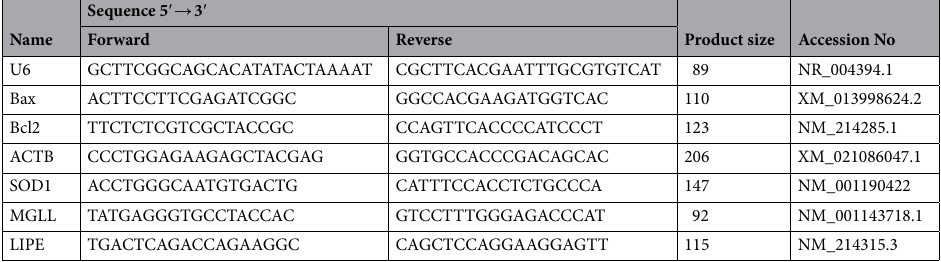
Table 1. Primers used for RT-qPCR. U6 RNU6-1 RNA, U6 small nuclear 1 ( house-keeping snRNA https:// www. ncbi. nlm. nih. gov/ gene/ 26827), Bax BCL2 associated X, apoptosis regulator ( causes apoptosis https:// www. ncbi. nlm. nih. gov/ gene/ 396633), Bcl2 BCL2 apoptosis regulator ( antiapoptotic https:// www. ncbi. nlm. nih. gov/ gene/ 10004 9703), SOD1 superoxide dismutase 1, MGLL Monoglyceride lipase, LIPE Lipase E, hormone-sensitive type. Cycling conditions of the PCR were 95 °C (1 min) for initial denaturation followed by forty cycles of 95 °C (5 s), 60 °C (30 s), and 72 °C (30 s). The specificities of primers were determined using the melting curve protocol from 65 to 95 °C and was confirmed with single peaks in the melt curves, gel electrophoresis, and DNA-free